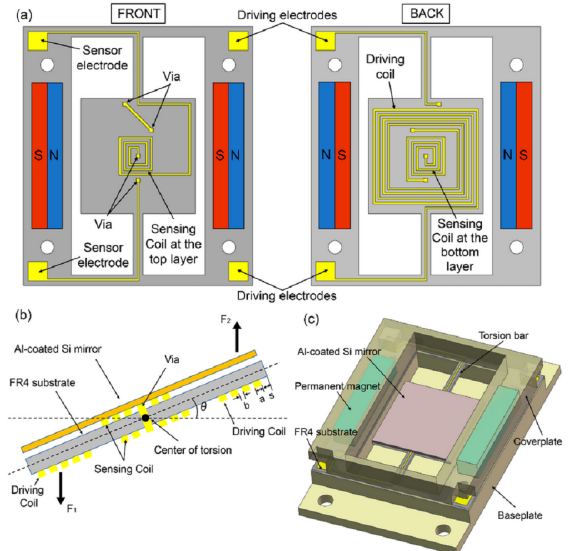
Figure 10. ( a ) Layout of the platform with double-layer copper coils; ( b ) electromagnetic actuation and sensing of the platform with the mirror plate; ( c ) schematic of the assembled scanning micromirror (reprinted from [126], copyright (2018), Creative Commons License).